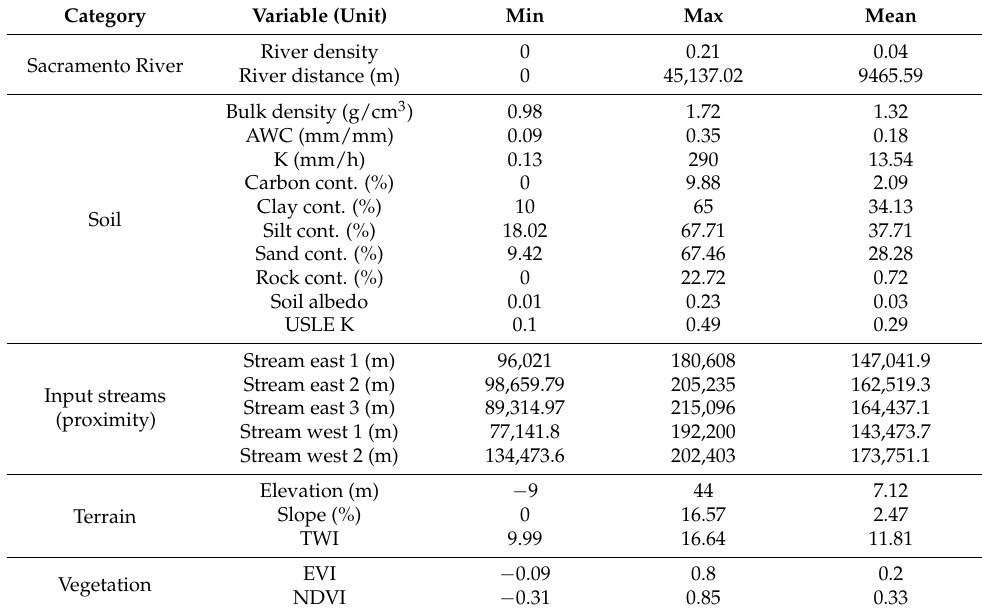
Table 1. The 22 environmental features used in the respective RF